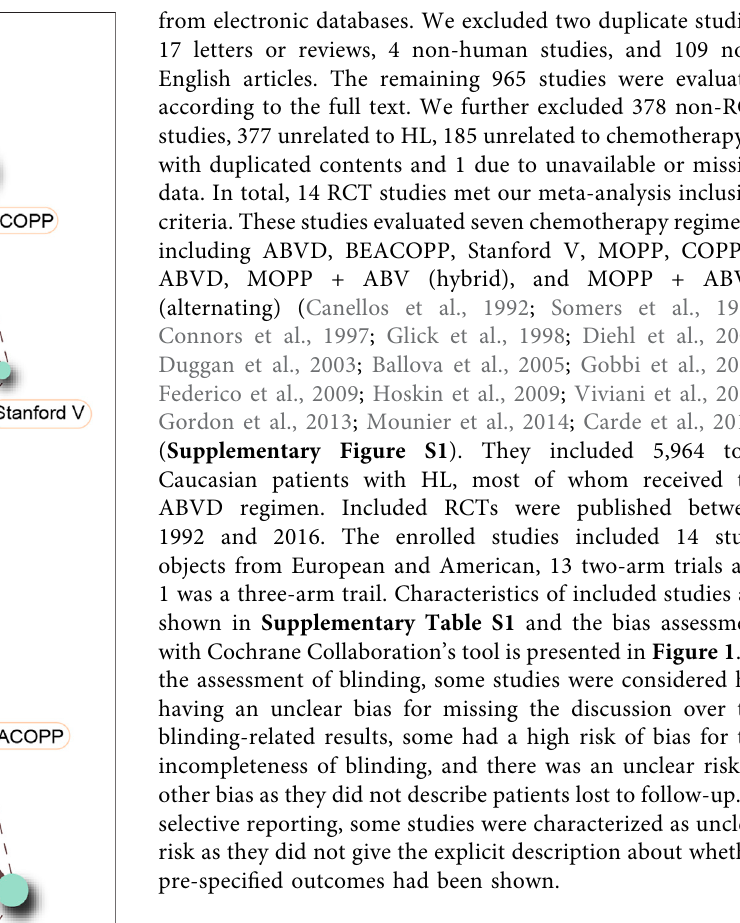
Frontiers in Pharmacology |